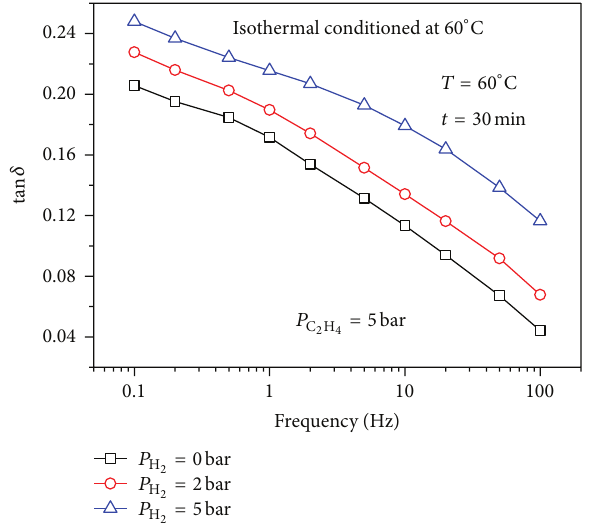
= 5 bar, C 2 H 4 time = 30 minutes polymerization